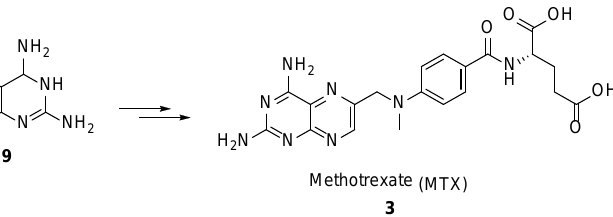
Scheme 2. Synthetic strategy towards MTX by the post-modification of 3,4-dihydropteridine-2,4-diamines 9